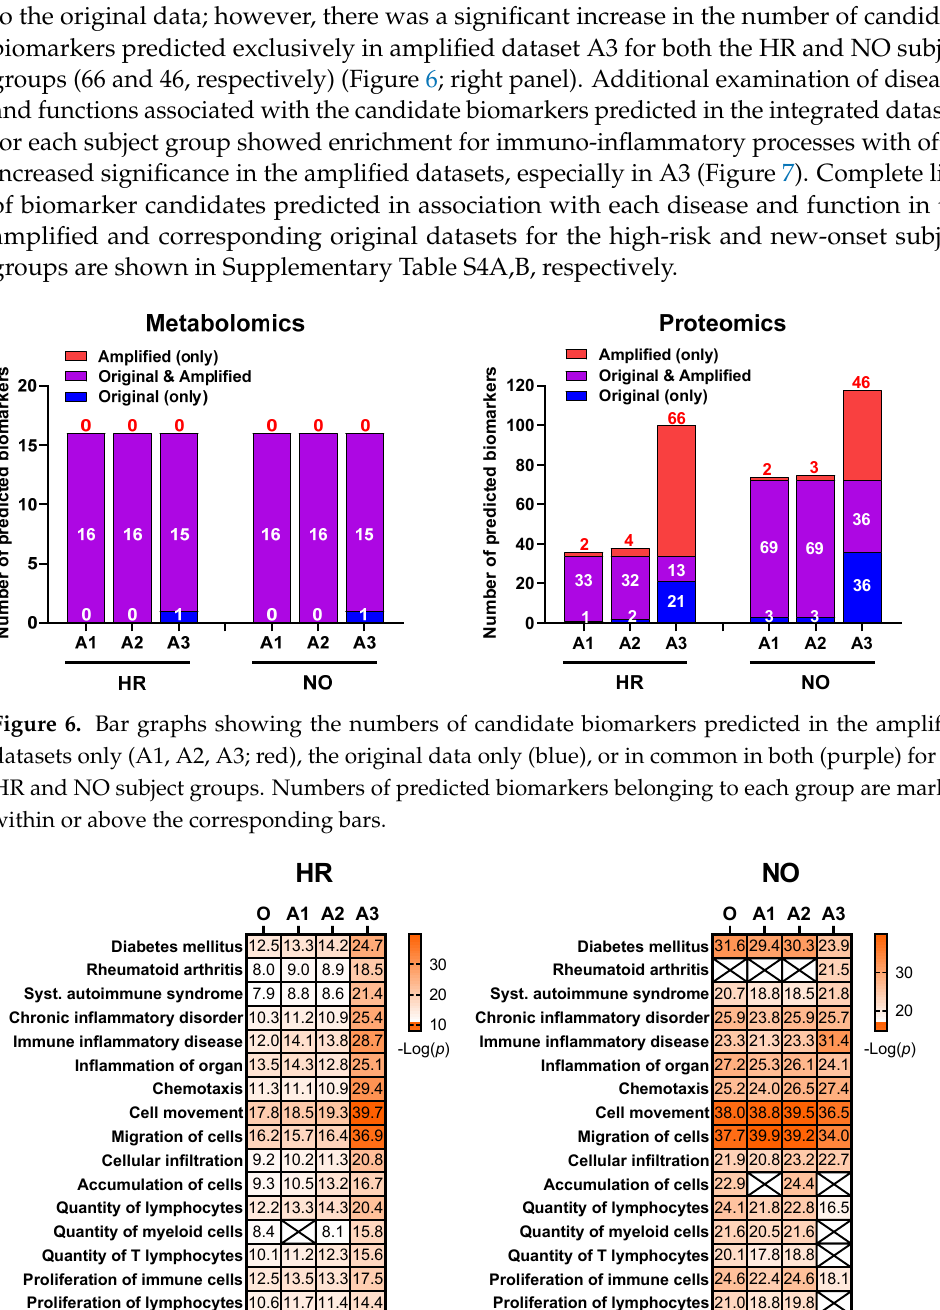
Figure 7. Heat maps showing selected diseases and functions that are enriched for immuno-inflammatory processes associated with candidate biomarkers predicted in the amplified integrated proteomics–metabolomics datasets (A1, A2, A3) in comparison to the original data (O) for the HR and NO subject groups. Values shown within the heat map cells correspond to the negative Log of the p -value assigned by IPA to each prediction based on Fisher’s tests. Cells marked with an X represent no prediction by IPA as of the date of analysis. See supplementary Tables S4A and S4B for complete lists of biomarker candidates associated with each predicted disease and function.